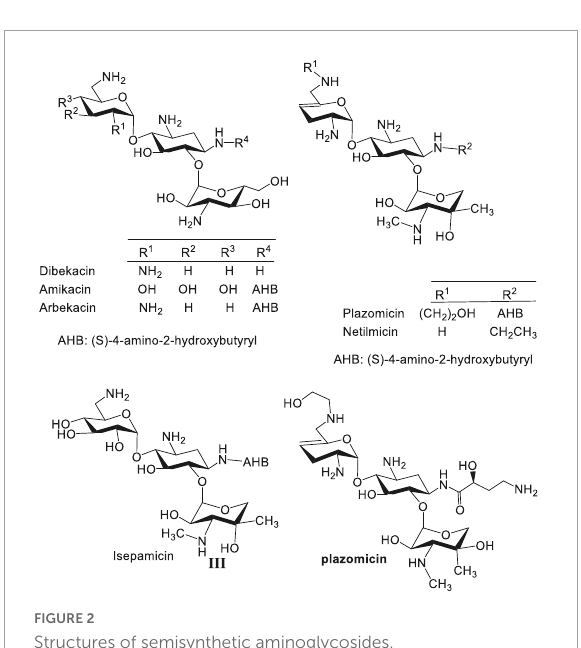
FIGURE2 Structures of semisynthetic